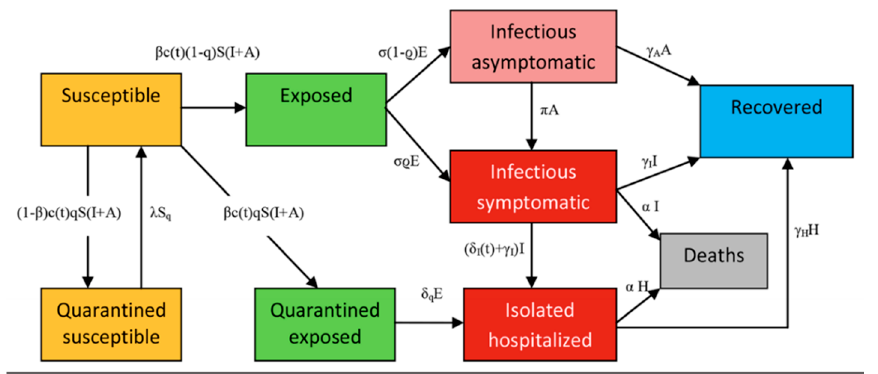
Figure 5. A simplified schematic diagram of the COVID-19 transmission model using SEIR model [32].